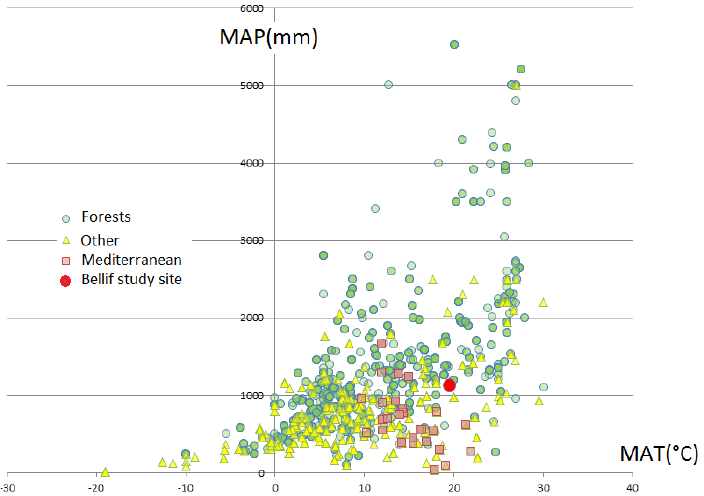
Figure 8. Bellif study site within the referenced study sites in the soil respiration global database [56] characterized by their Mean Annual Temperature (MAT, °C) and Mean Annual Precipitation (MAP,